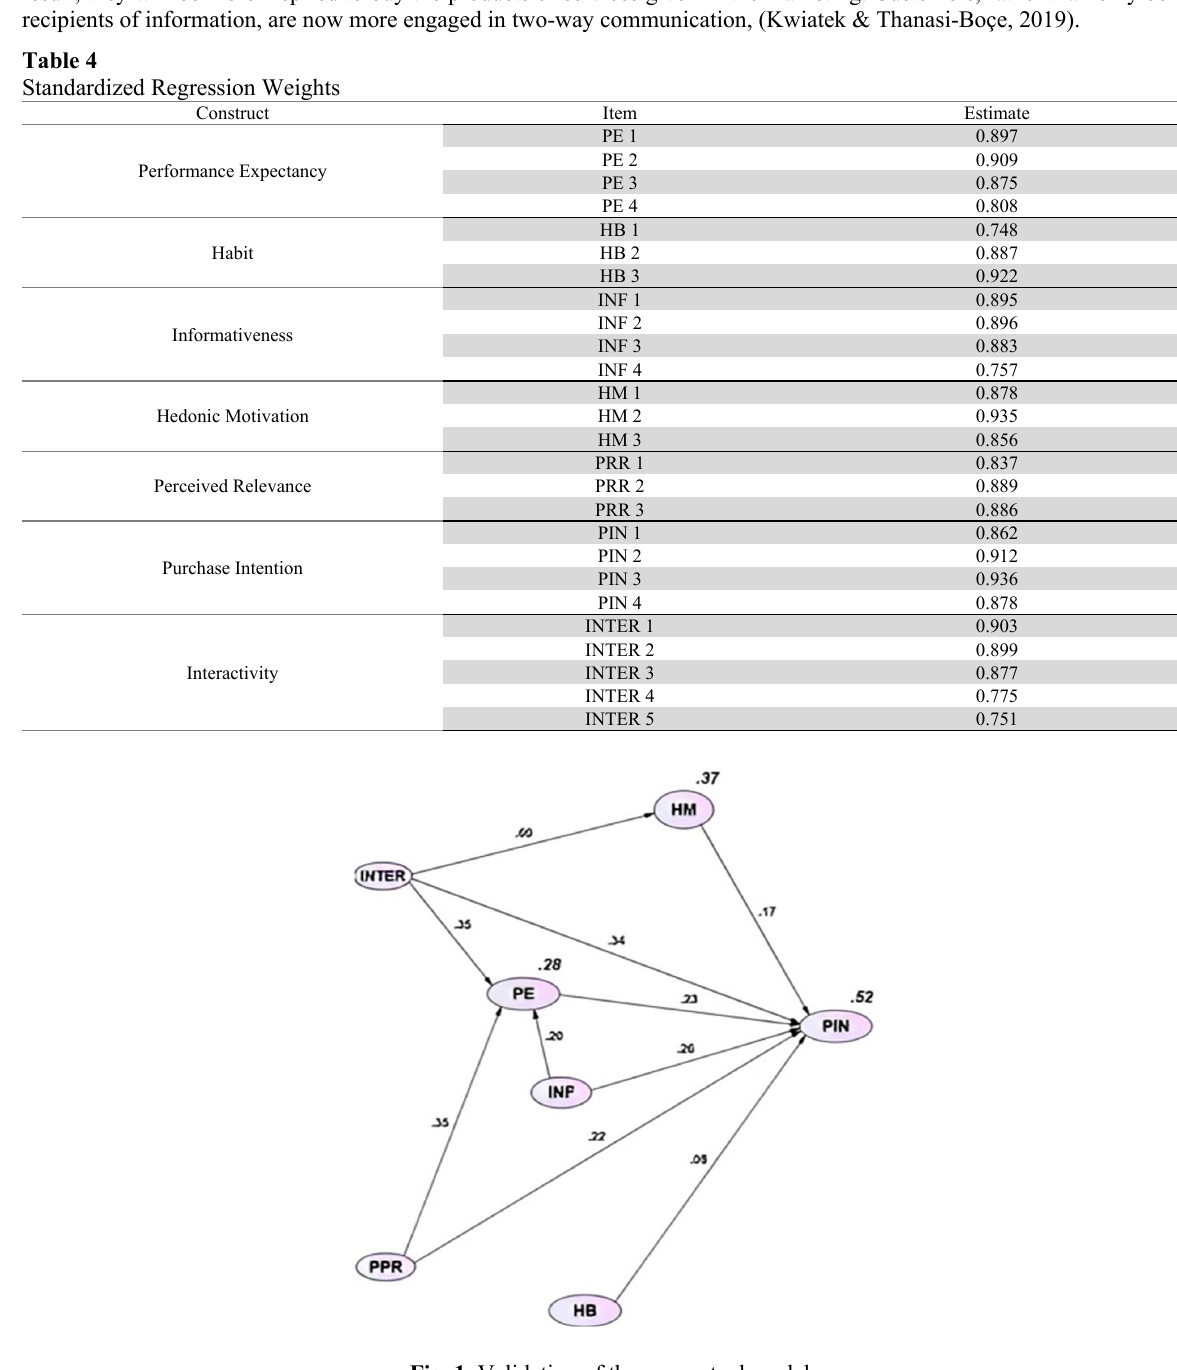
Fig. 1. Validation of the conceptual